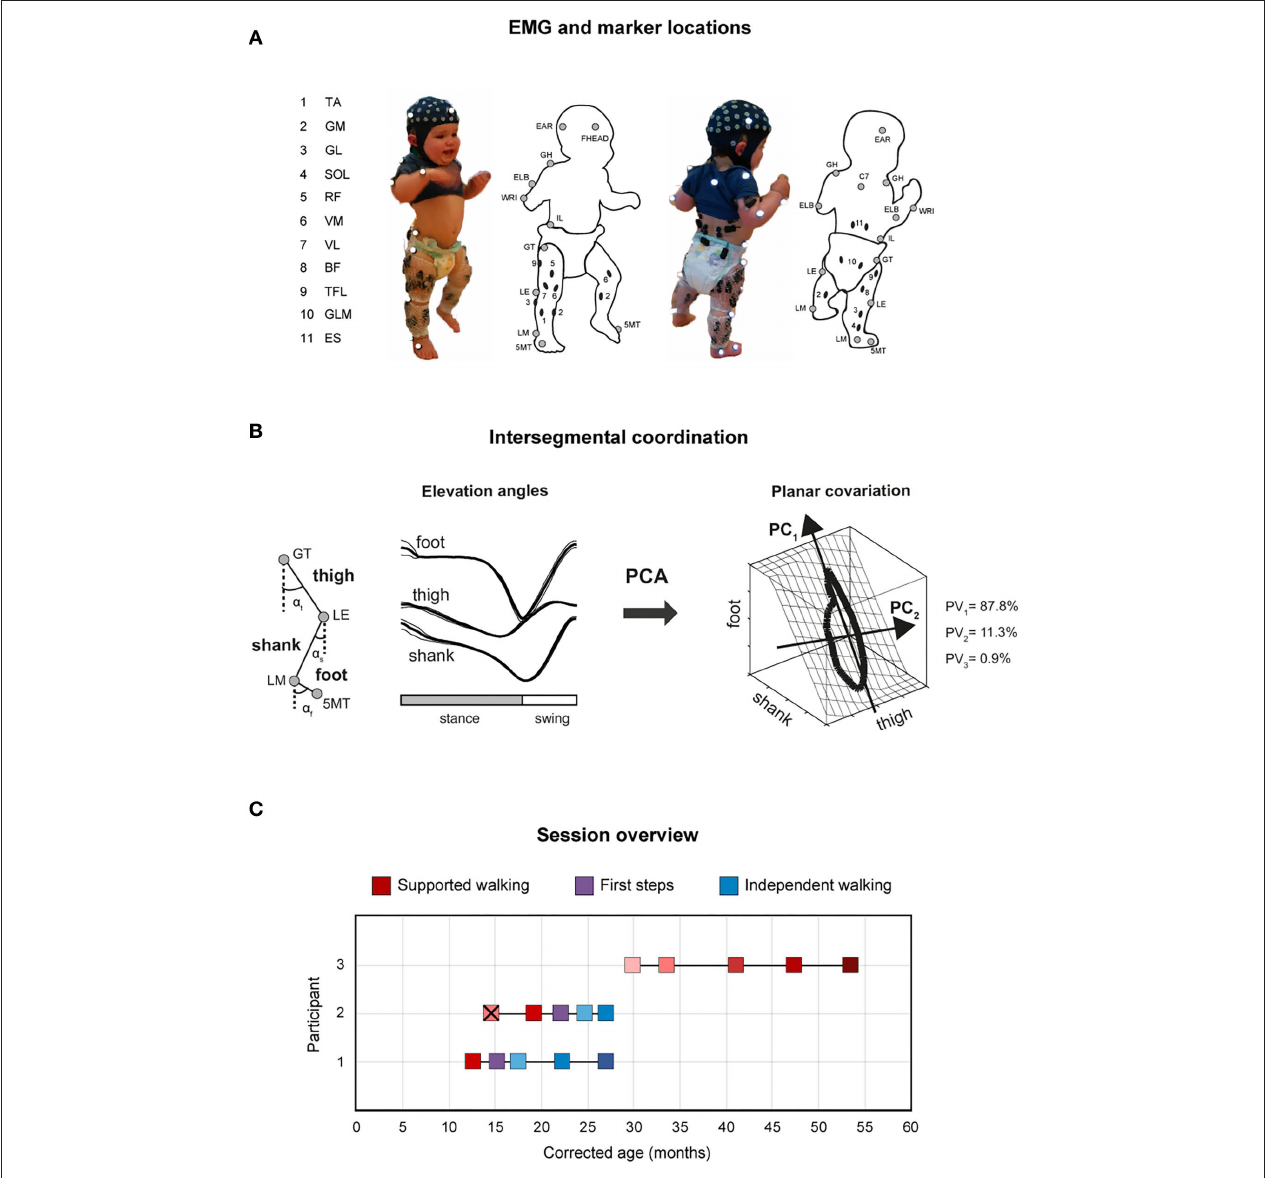
FIGURE 1 | Experimental setup and gait analysis session overview. (A) Marker locations are denoted by gray circles, and EMG electrode locations by black ovals. 5MT, head of fifth metatarsophalangeal joint; LM, lateral malleolus; LE, lateral femur epicondyle; GT, greater trochanter; IL, iliac crest; WRI, ulnar styloid; ELB, lateral humeral epicondyle; GH, glenohumeral joint; C7, seventh cervical vertebra; EAR, ear; FHEAD, forehead; TA, tibialis anterior; GM, gastrocnemius medialis; GL, gastrocnemius lateralis; SOL, soleus; RF, rectus femoris; VM, vastus medialis; VL, vastus lateralis; BF, biceps femoris; TFL, tensor fascia latae; GLM, gluteus maximus; ES, erector spinae at L2 level. (B) Schematic illustration of principal component (PC) analysis of elevation angles of lower limb segments (thigh: α t , shank: α s , foot: α f ), and its corresponding gait loop plotted three-dimensionally in one representative typically developing child (4 years old) during walking. A loop is obtained by plotting the thigh elevation angle vs. shank and foot elevation angles (after mean values subtraction). The shape and orientation of the gait loop reflect the coordination of limb segments as described by PC 1 (reflects the largest variance, which corresponds to the length of the gait loop), and PC 2 (the second largest variance, which corresponds to the width of the loop), here indicated with black arrows. Percentage of total variation explained by the three PCs (PV 1 -PV 3 ) are indicated. Note in adult and older children walking, two principal components typically account for ∼ 99% of the total variance (PV 3 = 0.9% in the example). (C) Gait analyses over time (corrected age, in months) for P1–P3 showing supported walking (SW: shades of red), first steps (FS: purple), and independent walking (IW: shades of blue). Different color shades from light to dark indicate the change in age and/or independent walking experience. P3 did not start to walk independently. X means the child did not take any steps during that